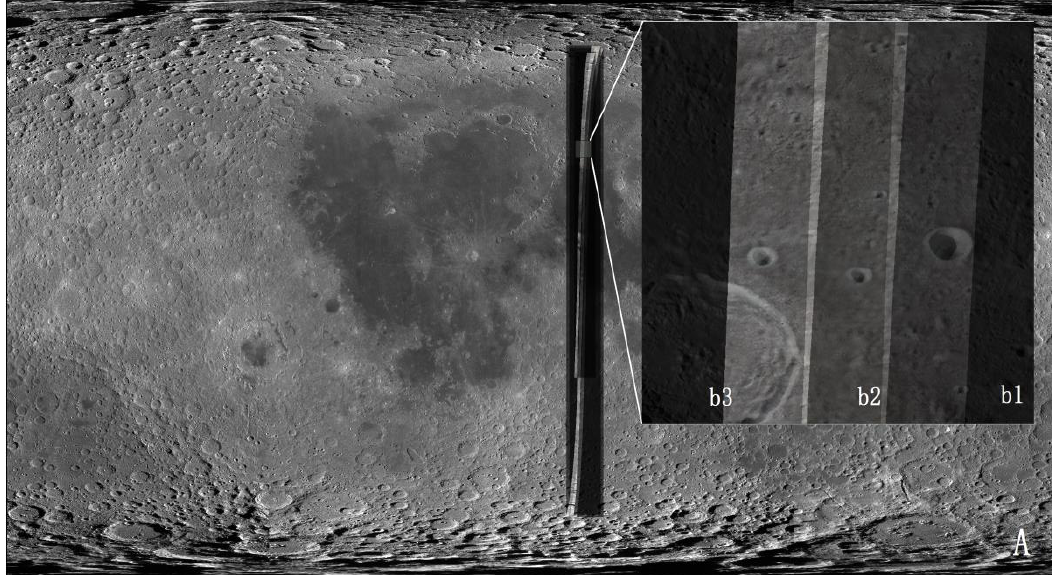
Figure 2. LROC image (A) and three orbiter images of IIM: image 2841(b1), image 2842 (b2), image 2843 (b3)